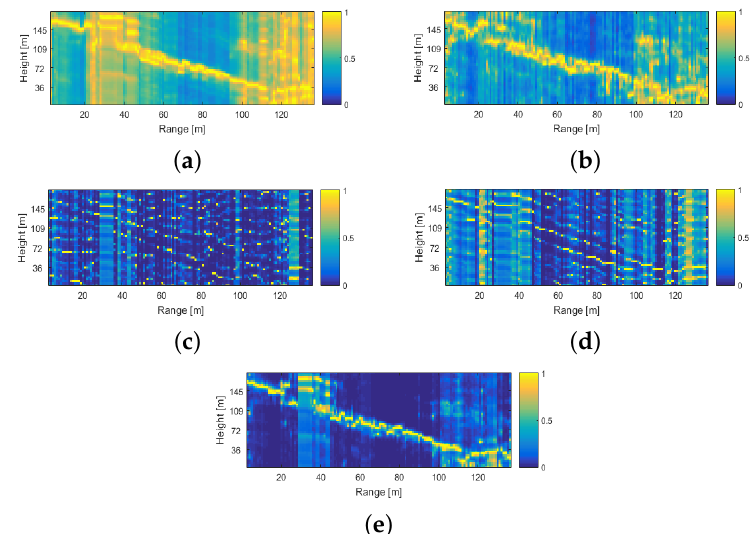
Figure 10. Tomograms of the yellow azimuthal line generated by the ( a ) Standard MUSIC estimator, ( b ) BIC-MUSIC estimator, ( c ) Minimum-Norm estimator, ( d ) Regularized Minimum-Norm estimator, and ( e ) proposed non-parametric MUSIC